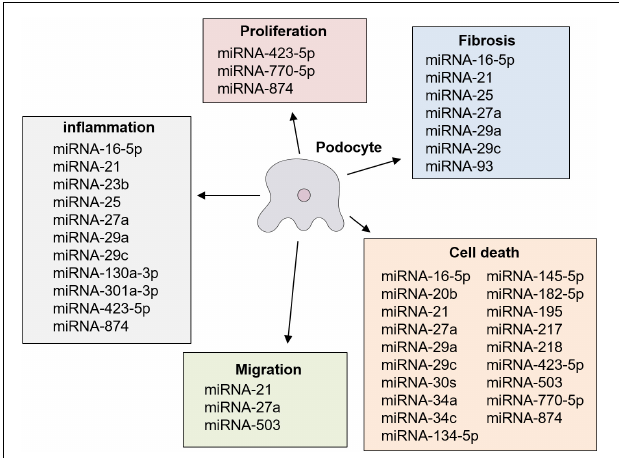
FIGURE 2 | Roles of miRNA in podocyte injury in diabetic